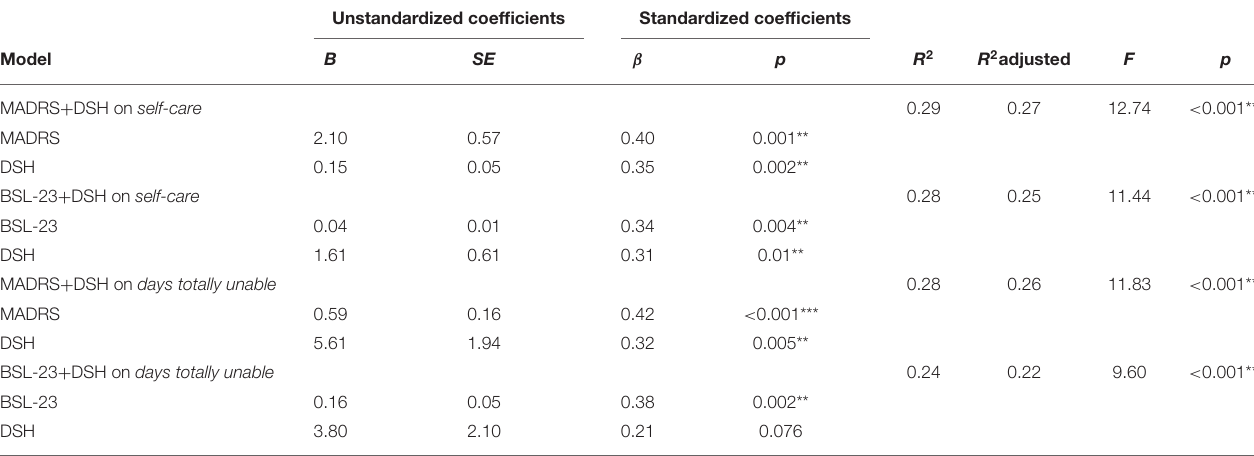
TABLE 3 | Regression analysis: The impact of depression, borderline symptoms and self-harm on self-care and days totally unable. Unstandardized coefficients Standardized